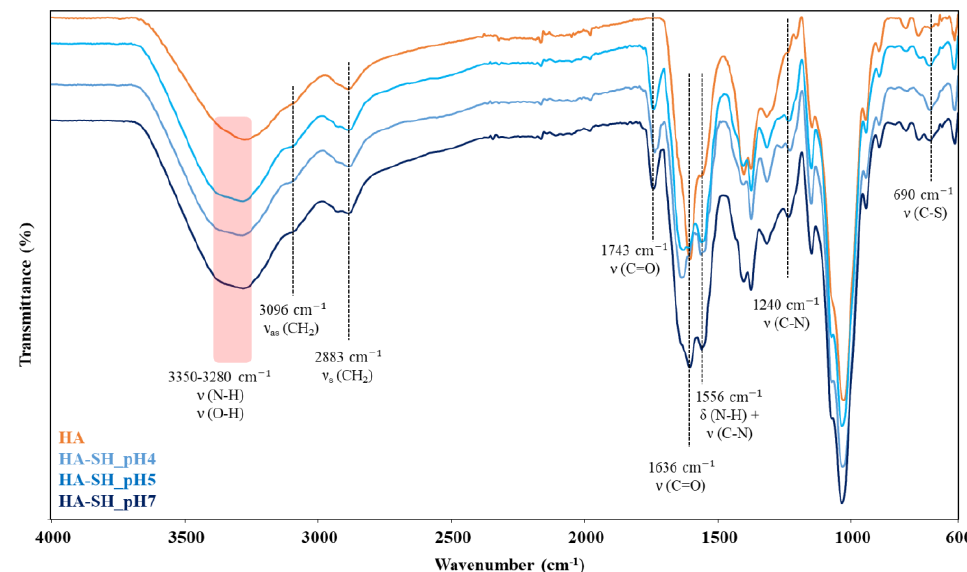
Figure 5. ATR-FTIR spectra of HA (orange), HA-SH_pH4 (light blue), HA-SH_pH5 (blue) and HA-SH_pH7 (dark blue). Black lines and the red color band identify the spectral regions in which HA-SH_pHX samples exhibit major differences compared to HA (control).